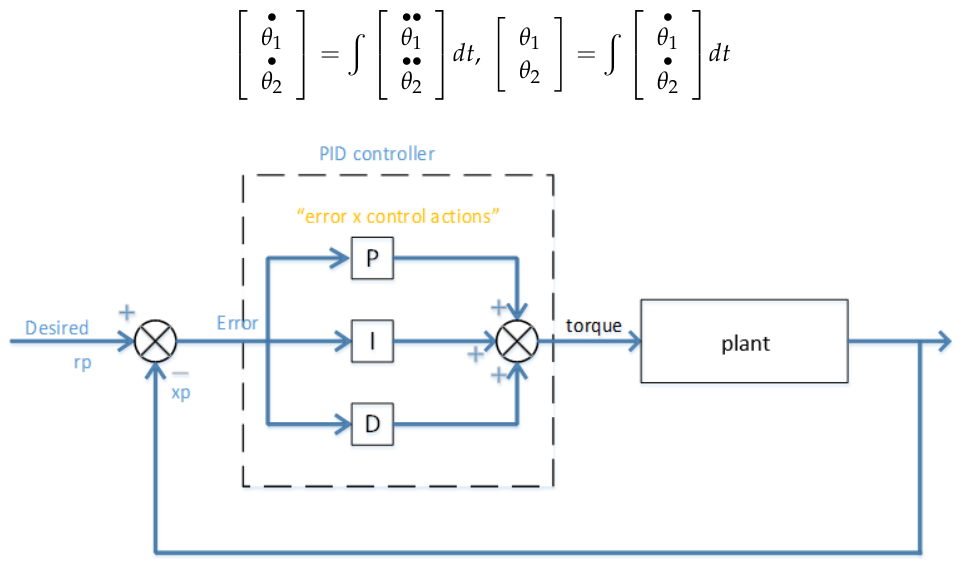
Figure 2. Proportional–integral–derivative (PID) control of the two-link manipulator.